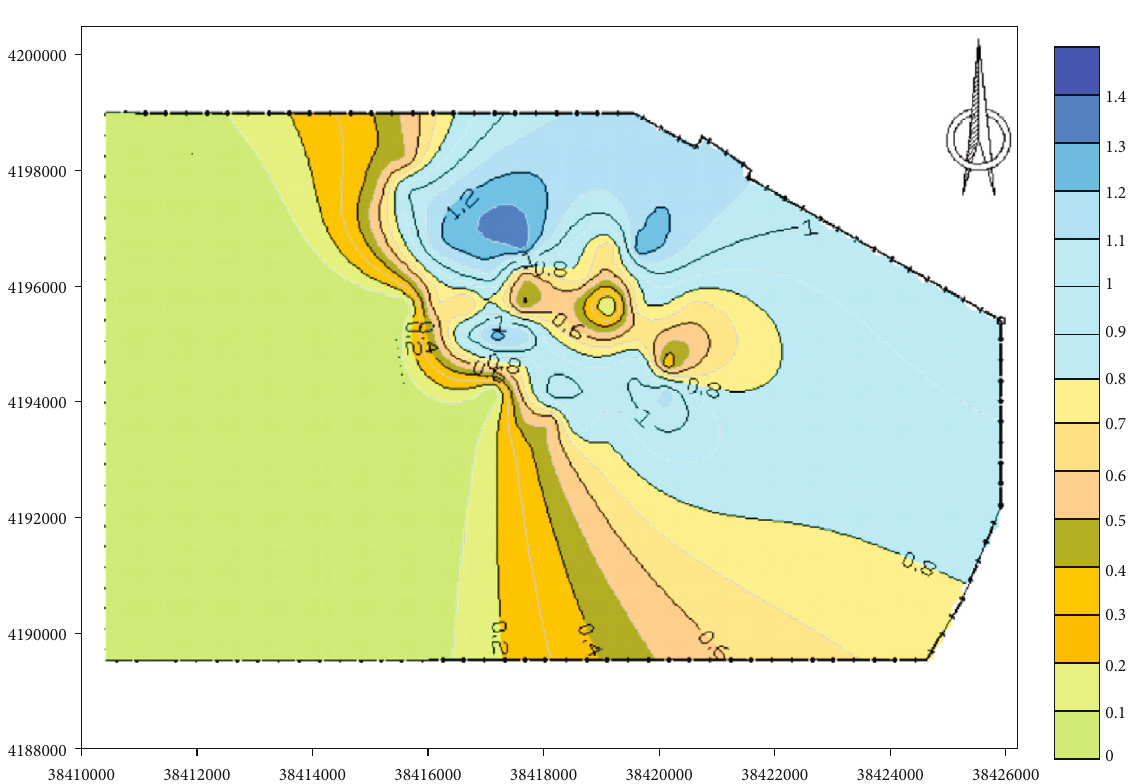
limestone water consumption. 2